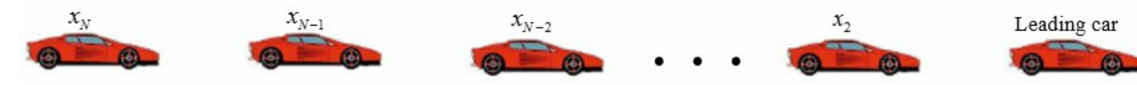
Figure 3. Cars moving on a straight road.